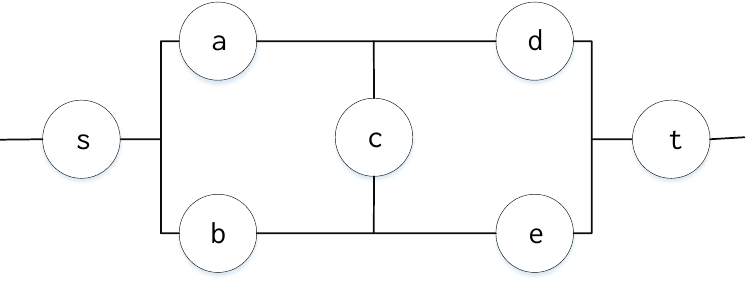
Figure 2. The extended bridge network.